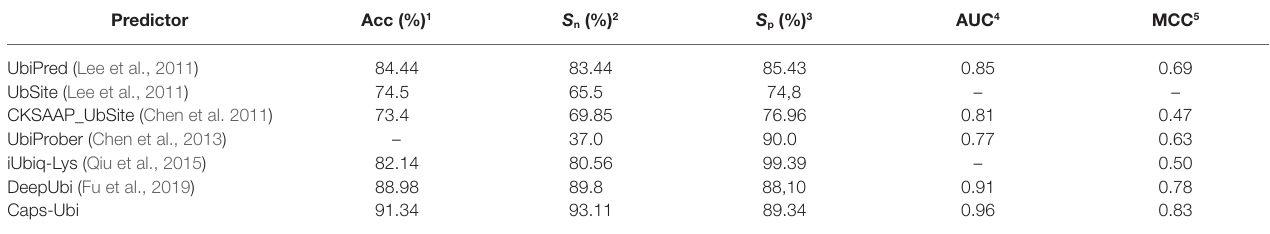
TABLE 5 | Proposed Caps-Ubi compared with other methods.